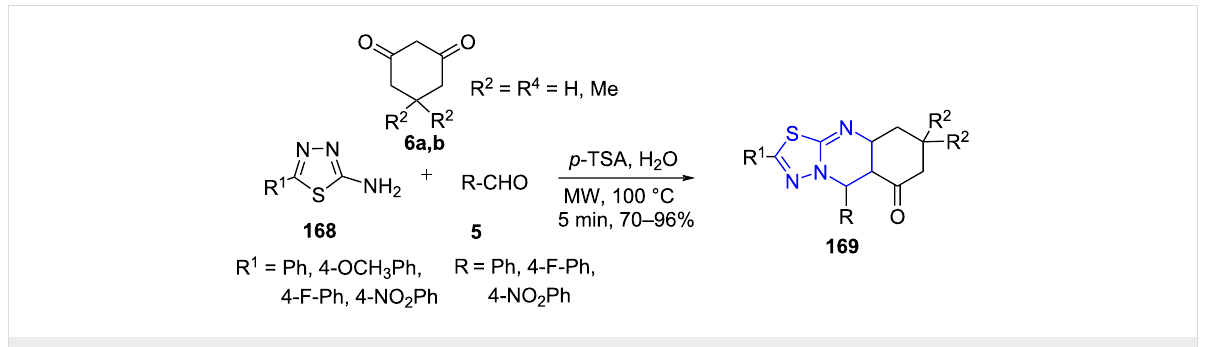
Scheme 69: On-water reaction for synthesis of